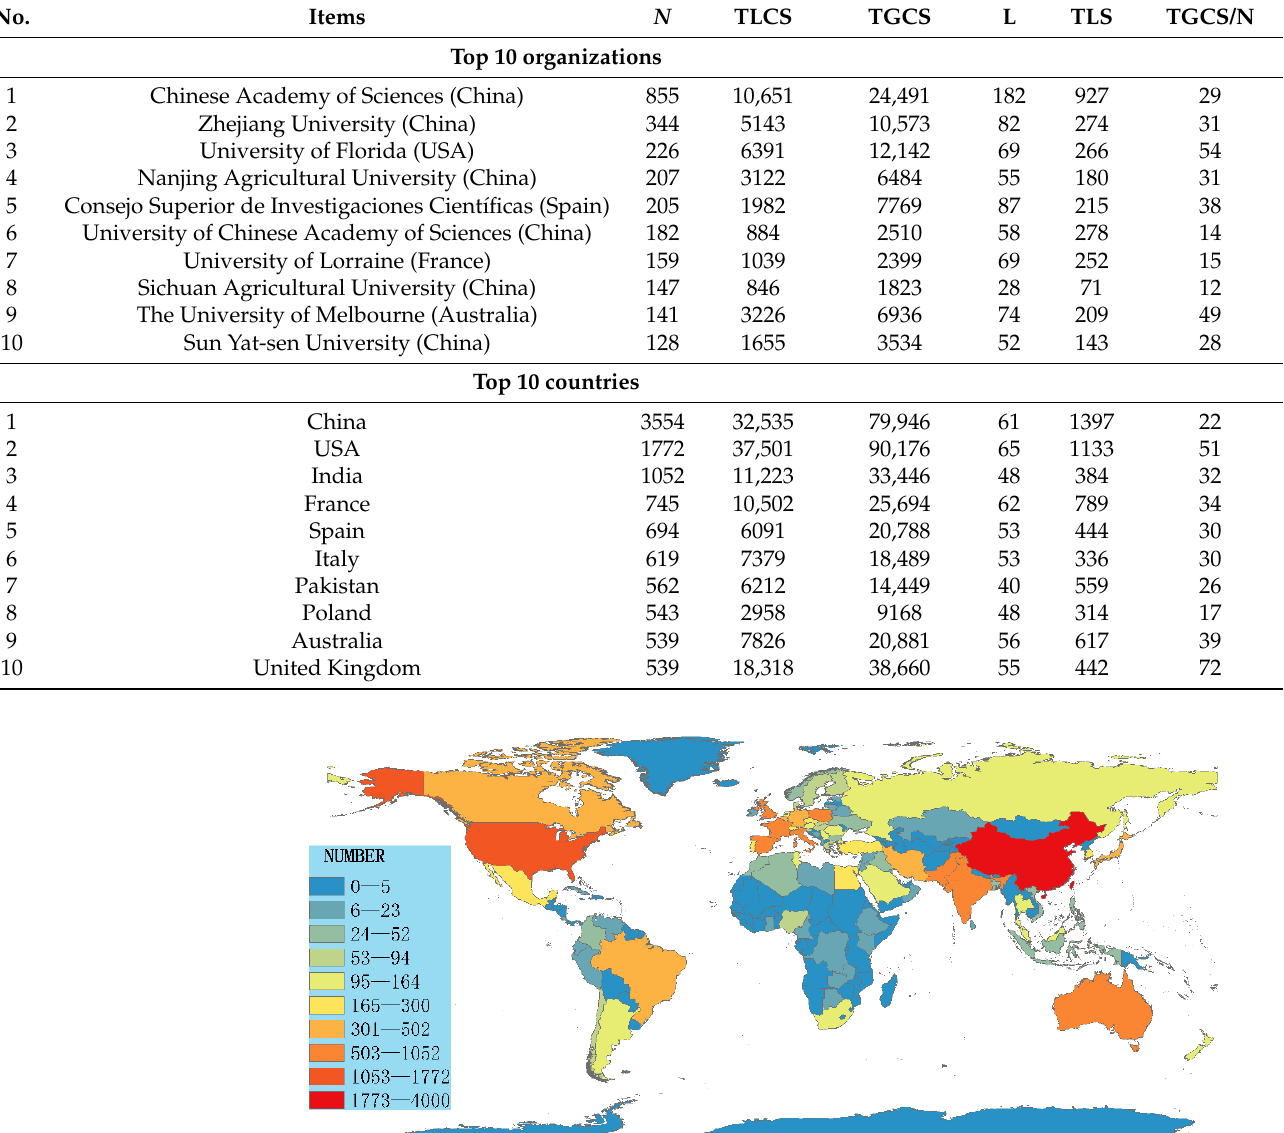
Table 1. The top 10 organizations and countries in overall strength of publications related to phytoremediation. The number of publications (N), total local citation score (TLCS), total global citation score (TGCS), total number of links (L), and total link strength (TLS) were obtained from the VOSviewer. TGCS/N is the per-article citations. No.